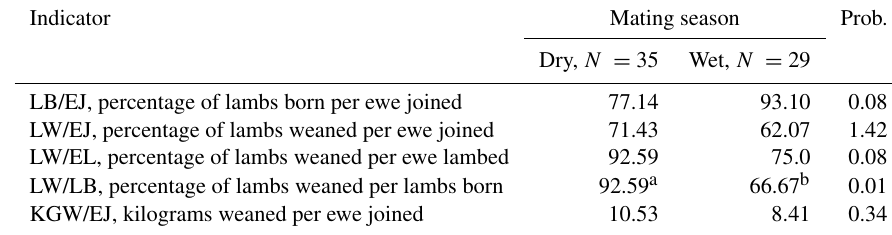
Table 6. Effect of dry and wet seasons on biological performance of Abou-Delik sheep. Indicator